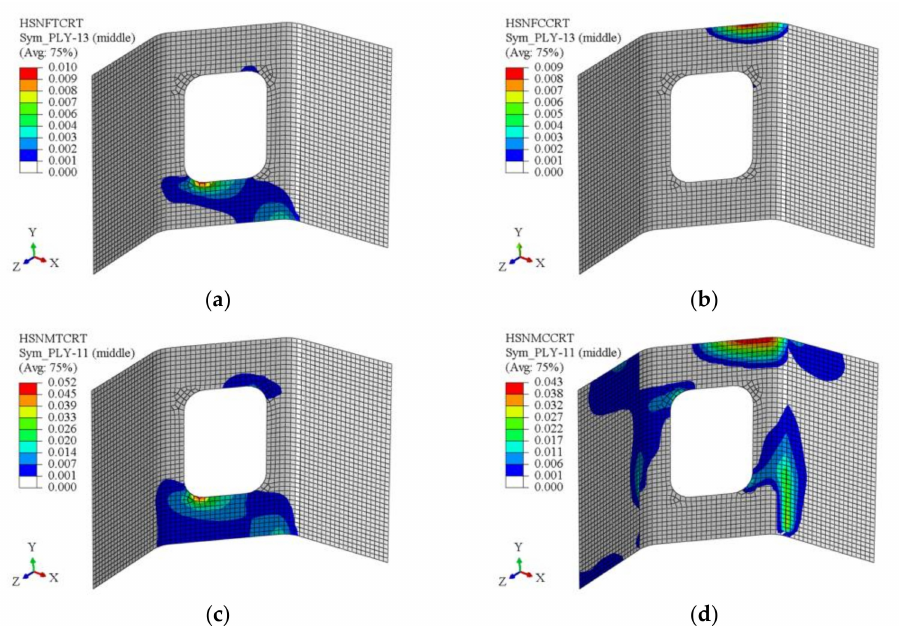
Figure 22. Values of output variables related to damage initiation criteria, at the most critical ply in Laminate 3 for each damage initiation mechanism, for bending moment M = 19.50 kN at the connection. ( a ) HSNFTCRT, max = 0.01, ( b ) HSNFCCRT, max = 0.01, ( c ) HSNMTCRT, max = 0.05, ( d ) HSNMCCRT, max =